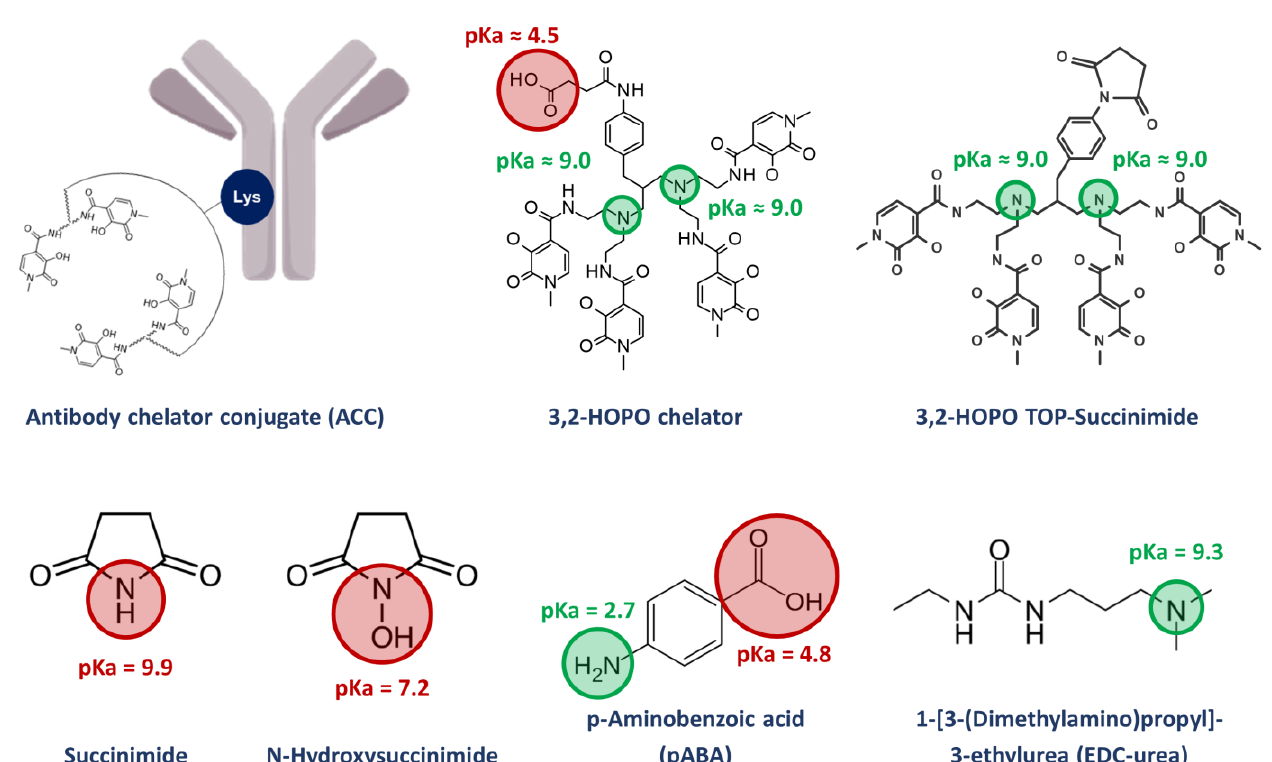
Figure 1. Synthesis impurities and stabilizer of the ACC with their respective pK a values.